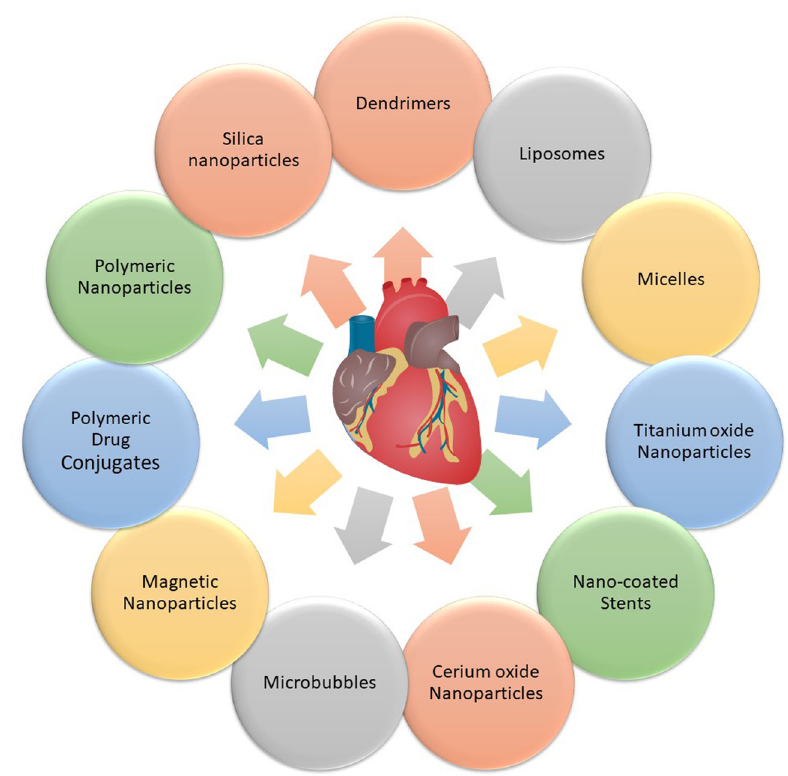
Figure 13: Nano - carriers for drug delivery to the